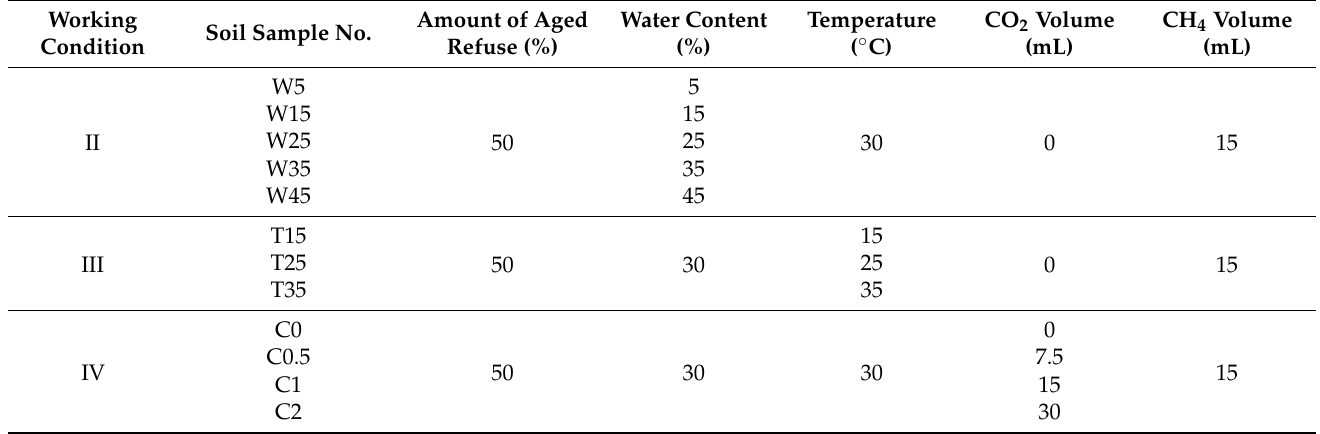
Table 3. Cont. Table 3. Incubation scheme of cover soil modified with aged refuse.